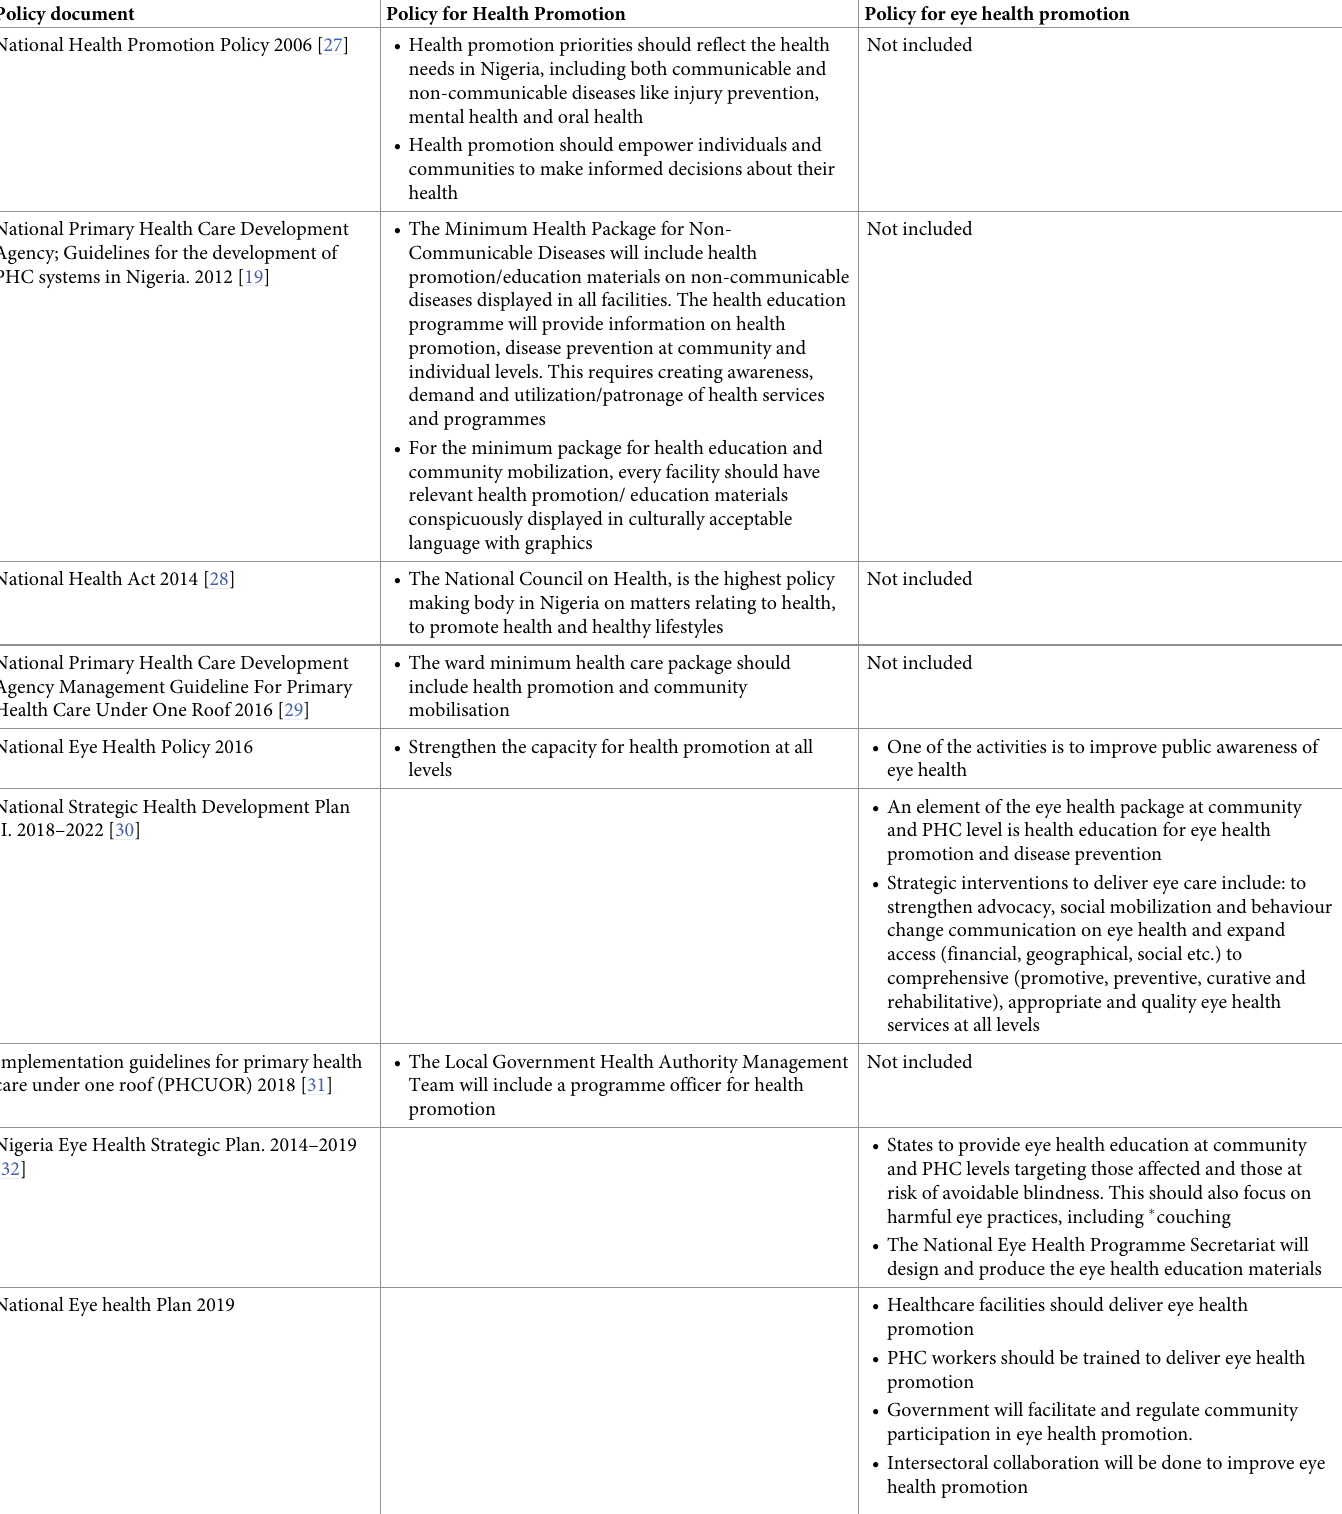
Table 1. National health documents that support health promotion and eye health promotion in